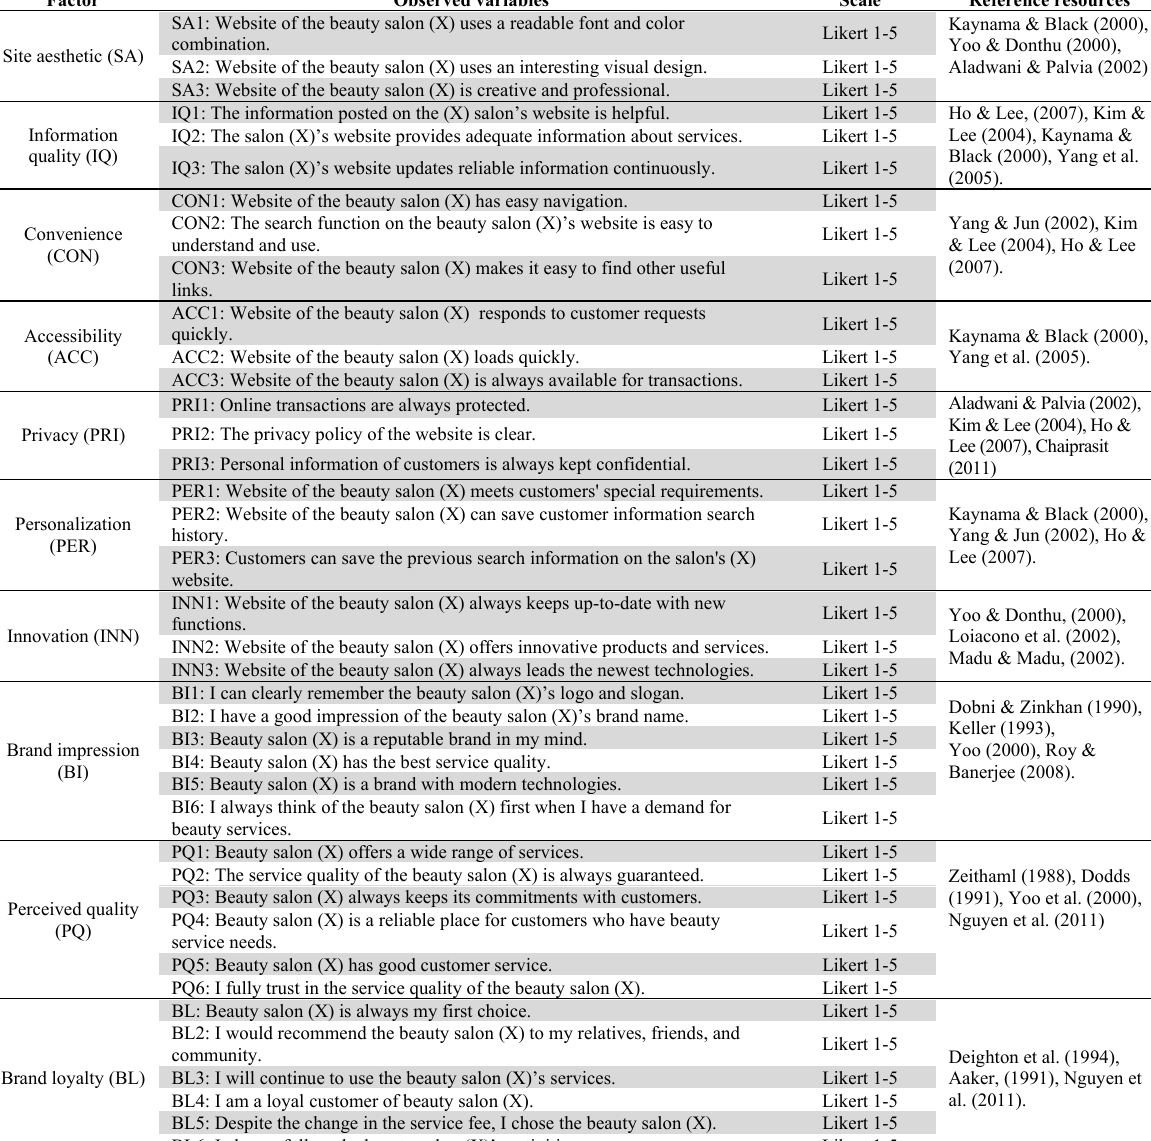
Interpretation of observed variables in the research model Factor Observed variables Scale Reference